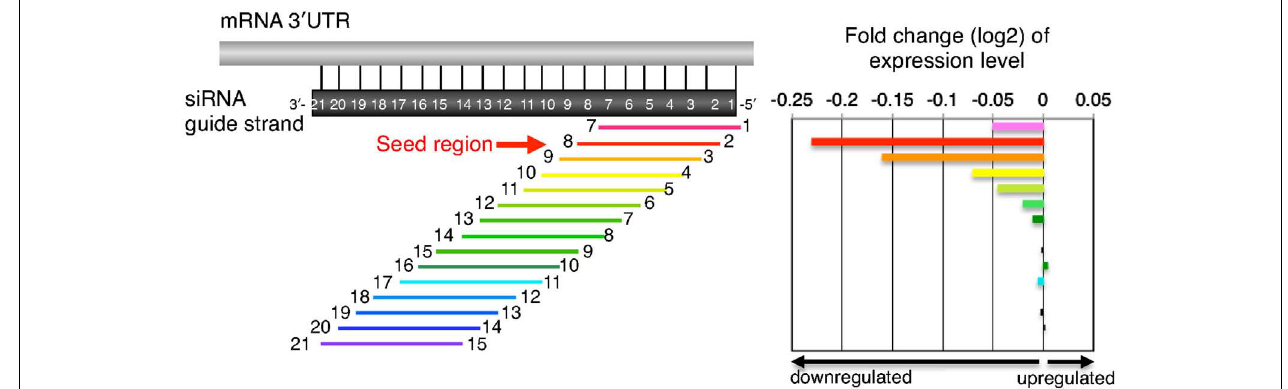
1–7 of the siRNA guide strand and vice versa.The horizontal arrow indicates a transcript group with seed complementarity. In the right panel, changes in gene expression levels are shown by log2 of fold change ratio to mock transfection. Note that the groups of transcripts labeled with 2–8 are the most sensitive to the off-target effects, suggesting that guide strand nucleotides 2–8 serve as a “seed.”